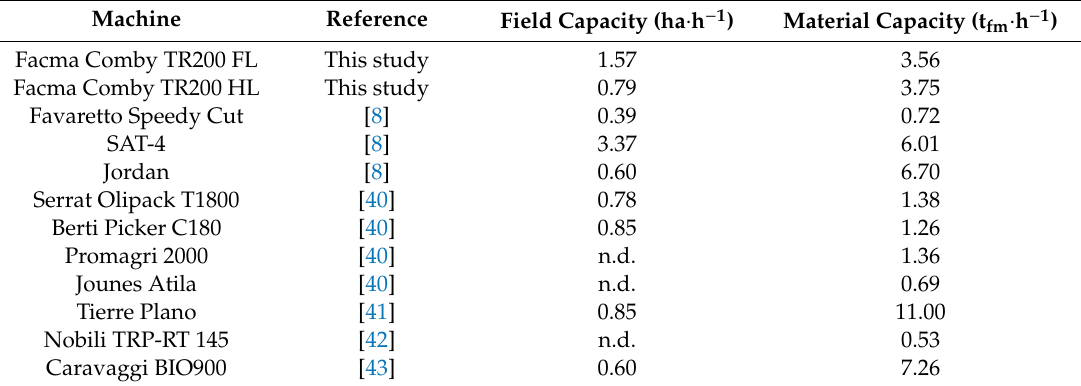
Table 7. Comparisons between the field capacity and the material capacity of the Facma Comby TR200 and other machines for olive pruning